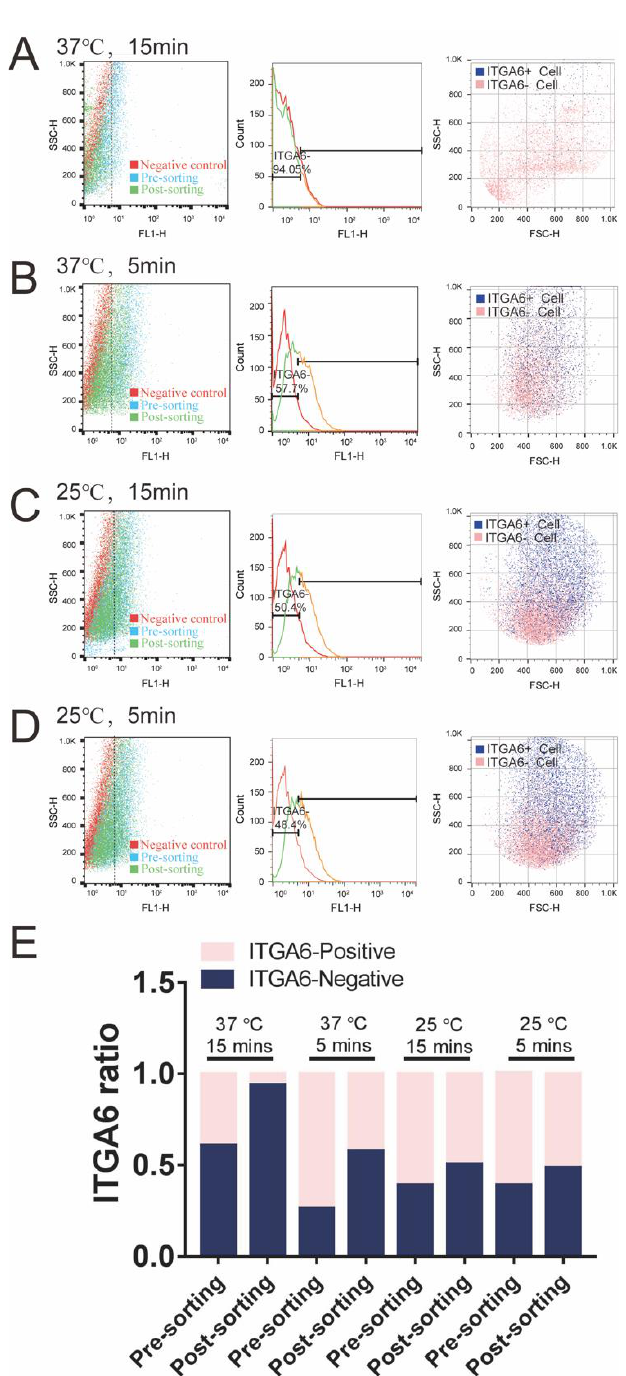
Figure 5. The IP-based purification of ITGA6-negative iPSC-TM. The ratio of the ITGA6-negative cells after the IP-based sorting by oscillation at different conditions: ( A ) at 37 ◦ C every 15 min; ( B ) at 37 ◦ C every 5 min; ( C ) at 25 ◦ C every 15 min; and ( D ) at 25 ◦ C every 5 min. ( E ). Quantification analysis of the ratios of the ITGA6-positive cells (pink) and ITGA6-negative cells (blue).